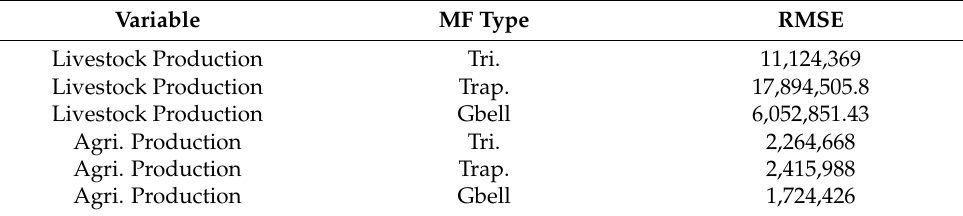
Table 5. RMSE results for ANFIS models with different MF types in the testing phase. Variable MF Type RMSE Livestock